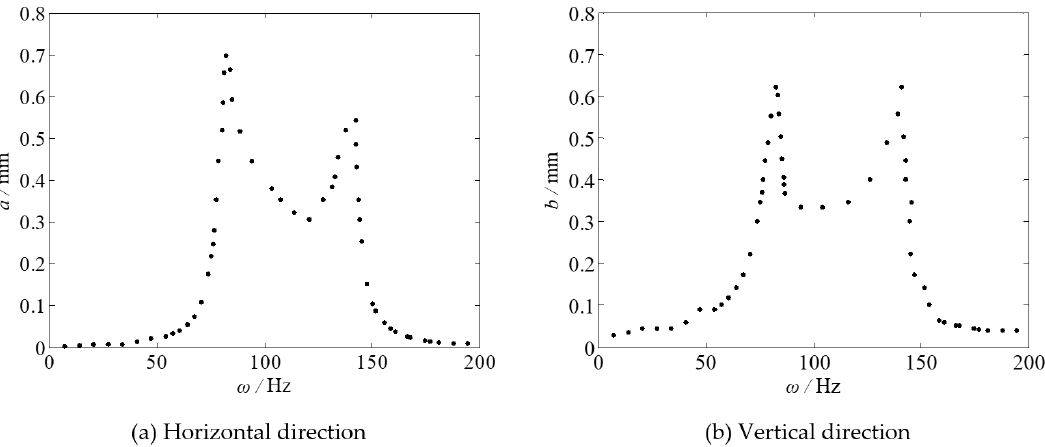
Figure 11. Amplitude–frequency curve of the coupled vibration system of a hot rolling mill. ( a ) Amplitude–frequency curve of horizontal direction; ( b ) Amplitude–frequency curve of vertical direction.